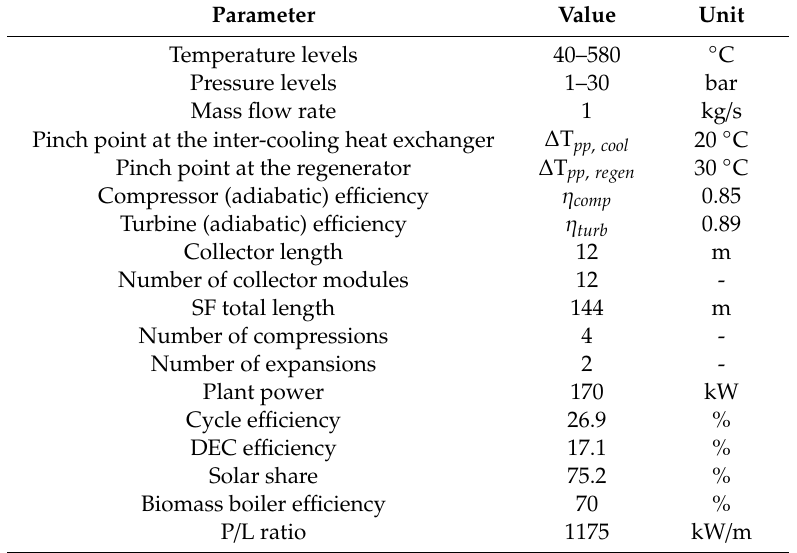
Table 4. DEC-based plant